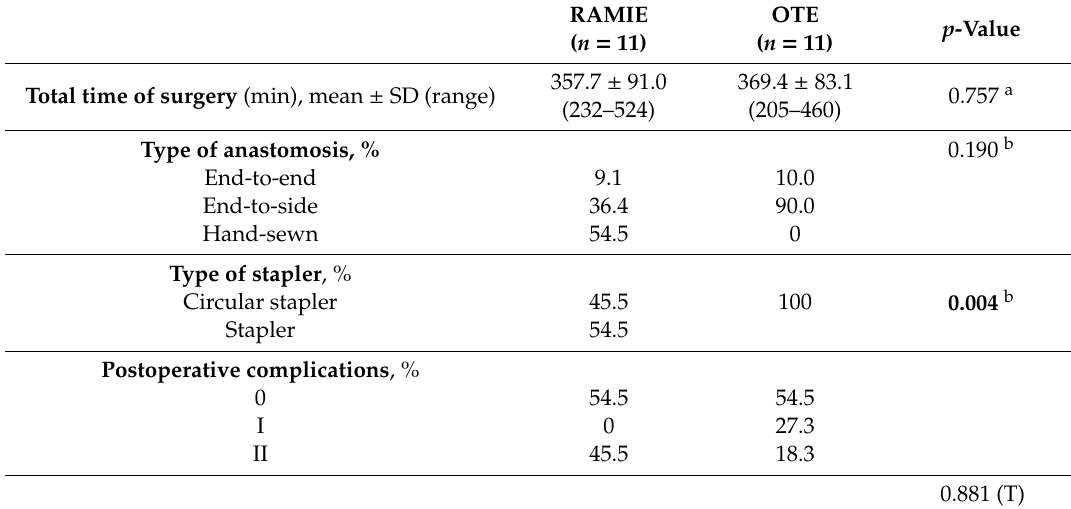
Table 4. Surgery-associated characteristics of propensity score-matched cohorts stratified by surgical approach (RAMIE vs. OTE). Total time of surgery (min), mean ± SD